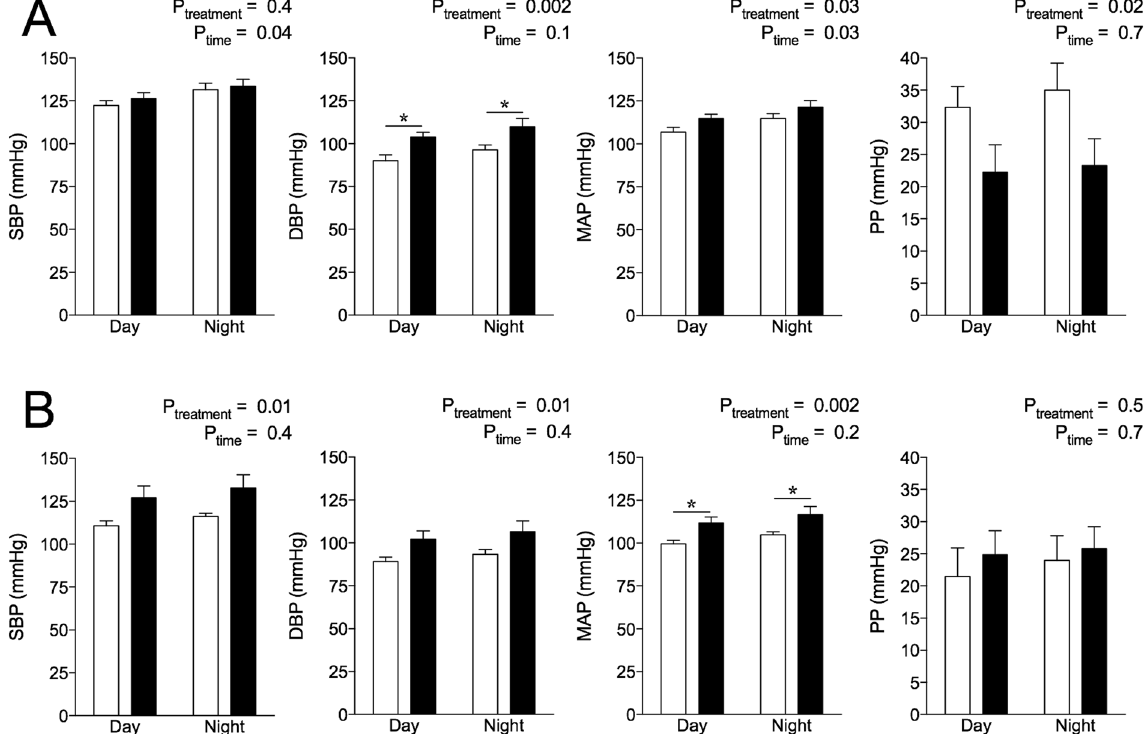
Figure 1. Blood pressure (mmHg) profiles of offspring at 12 months of age. Systolic blood pressure (SBP), diastolic blood pressure (DBP), mean arterial pressure (MAP) and pulse pressure (PP) in male ( A ) and female ( B ) offspring. Data analysed via two-way ANOVA. Values are mean ± SEM. * P < 0.05 by Sidak post hoc . Control: open bars; hypoxia: closed